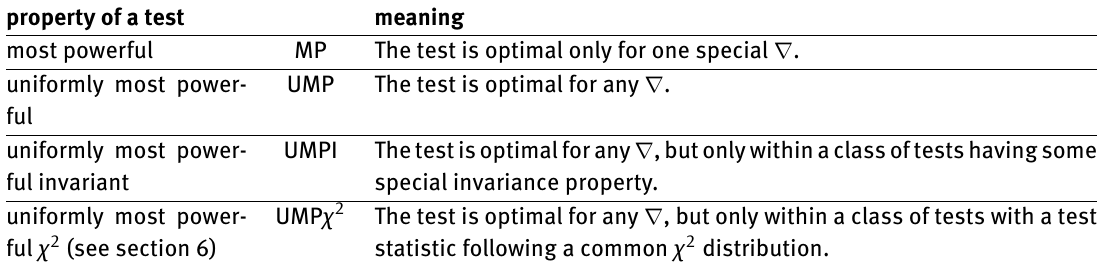
Table 1: Optimal tests in the sense of maximum power in Eq. 24 for given size α in Eq. 20 property of a test